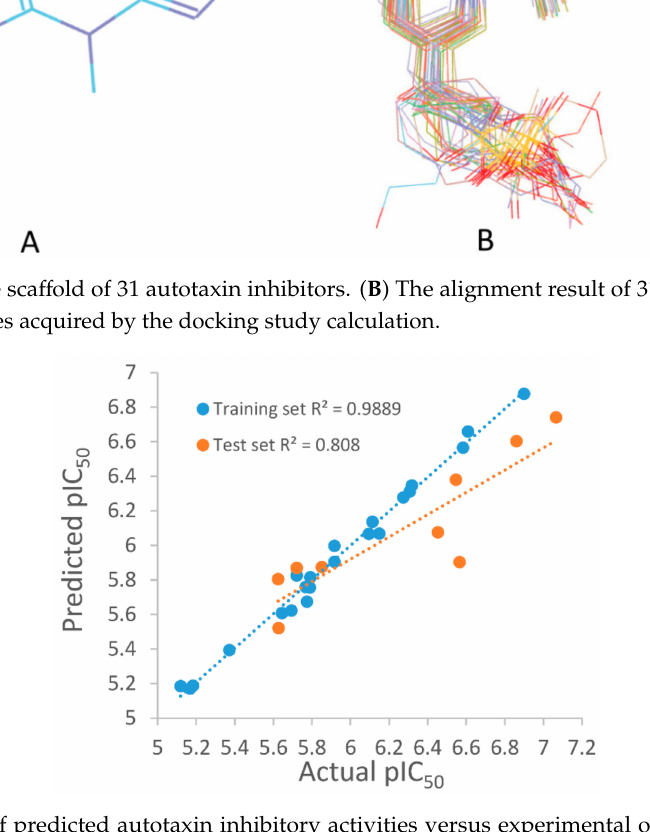
Figure 6. Plots of predicted autotaxin inhibitory activities versus experimental of training set and test